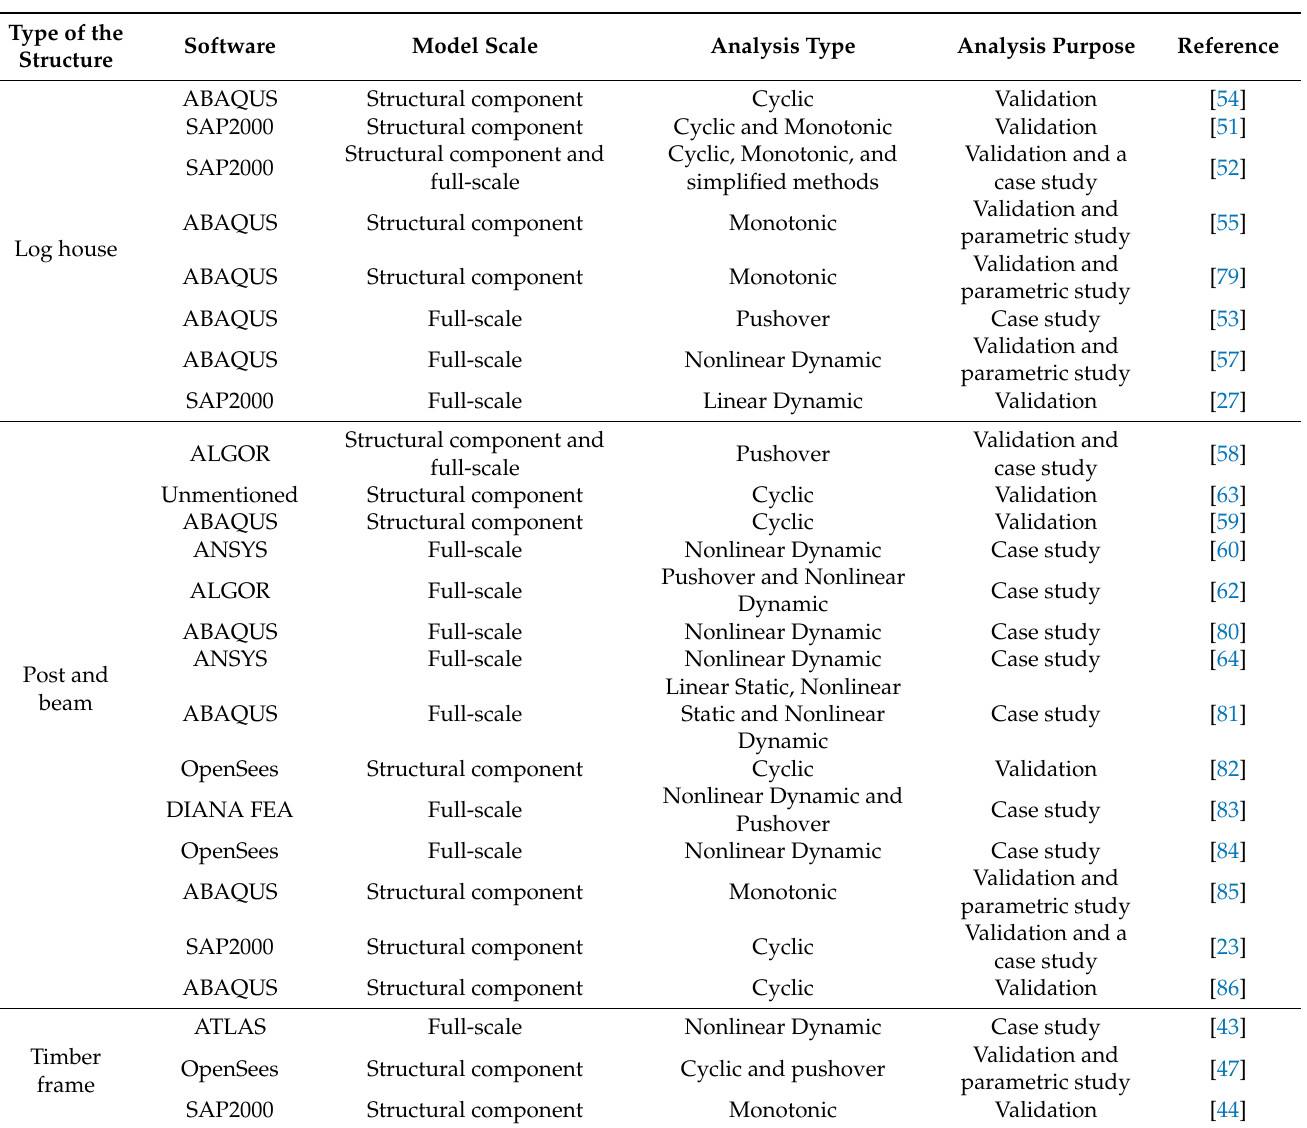
Table 2. Numerical modeling and analyses method of various research